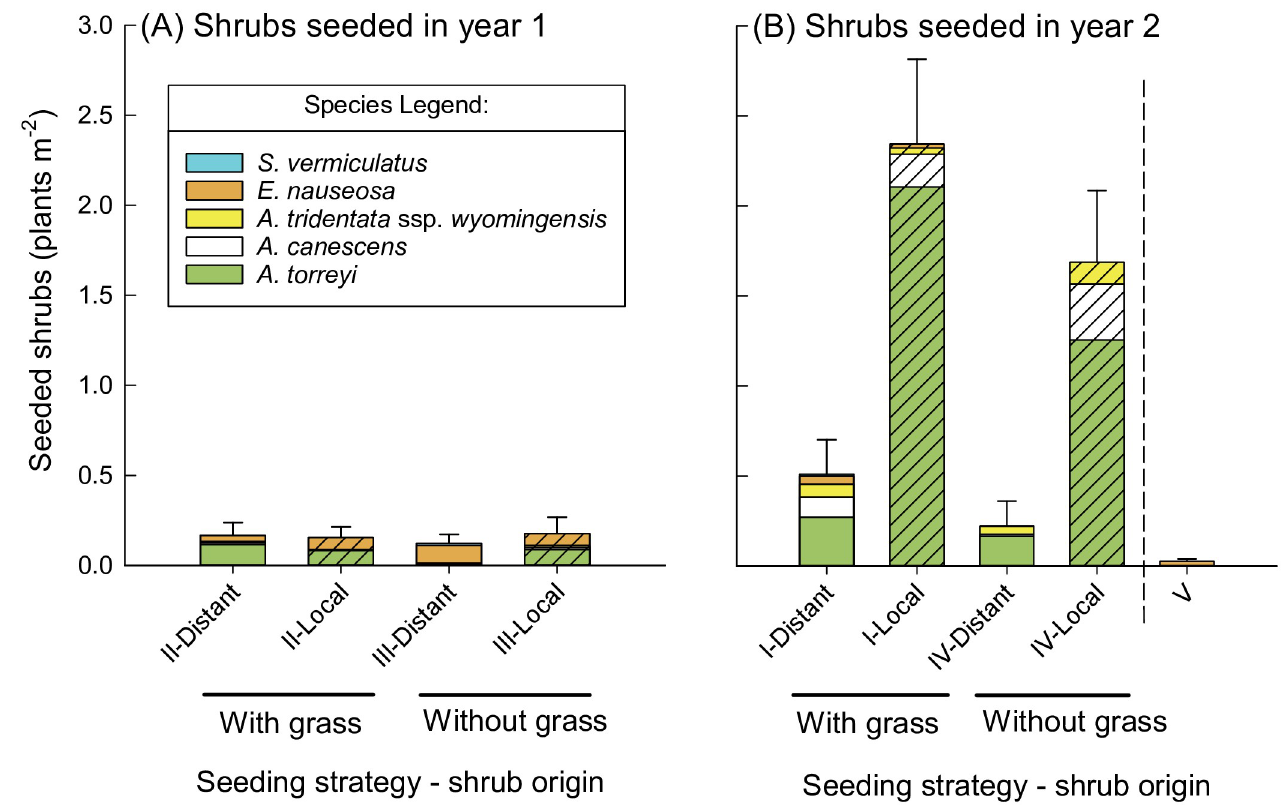
Fig 3. Seeded shrub density in the South Field in May 2016, by seeding strategy and shrub origin. Seeded shrub density (plants m -2 ) in the South Field in May 2016, shown by seeding strategy (I-V; see Table 1) and shrub origin, when shrubs were seeded in year 1 (A) and in year 2 (B), either with or without grasses. “Distant” and “Local” on the X-axis refer to shrub seed origin, which is also indicated by hash marks for local origin, or no pattern for distant origin. Strategy V (unseeded control) is shown in panel (B) for visual comparison of shrub recruitment in areas that did not receive seed addition. There were no differences between irrigation treatments (Table 2(i), S5 Appendix), so results shown here are combined.